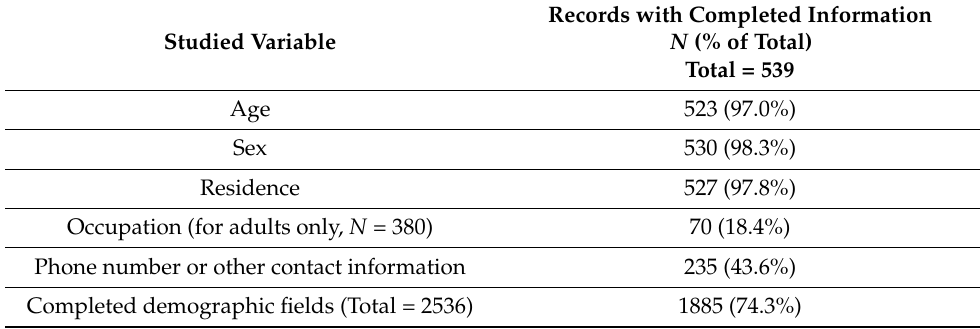
Table 1. Availability of demographic information in the medical records of trauma